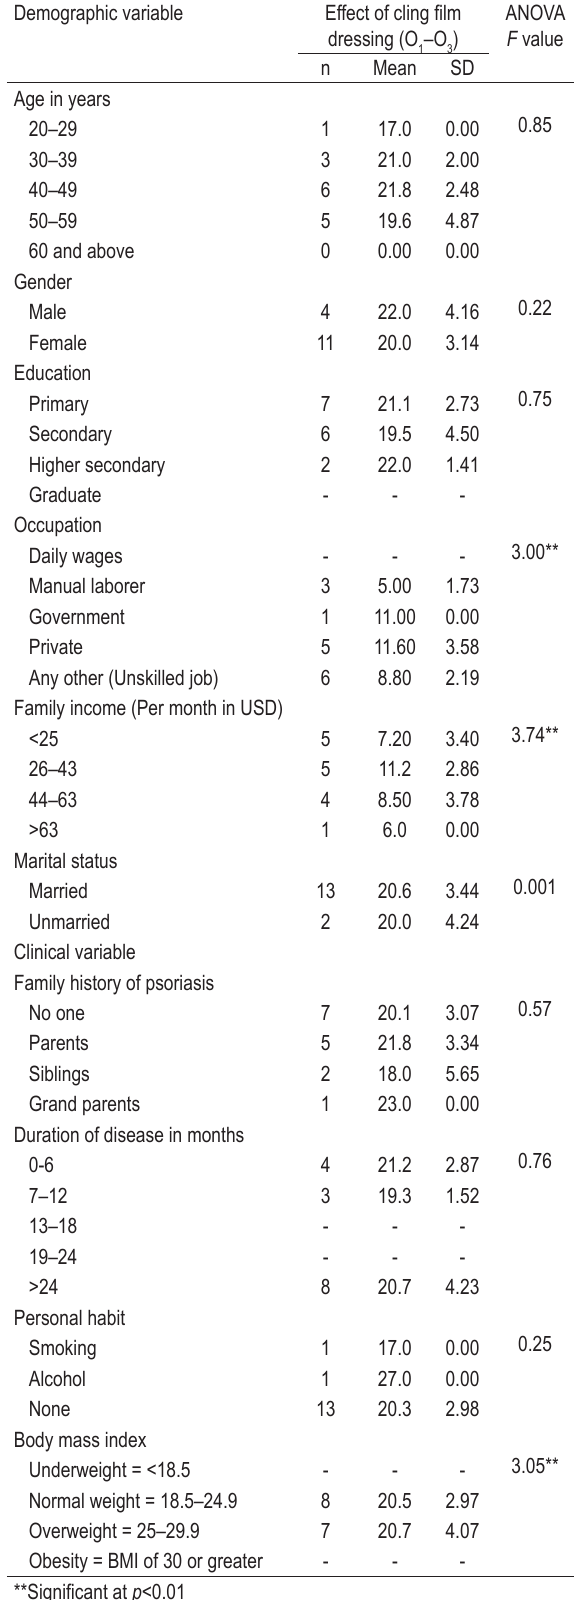
TABLE 5. ANOVA of demographic and clinical variable with the efficacy of cling film dressing in the post‑test I and II among study group Demographic variable Effect of cling